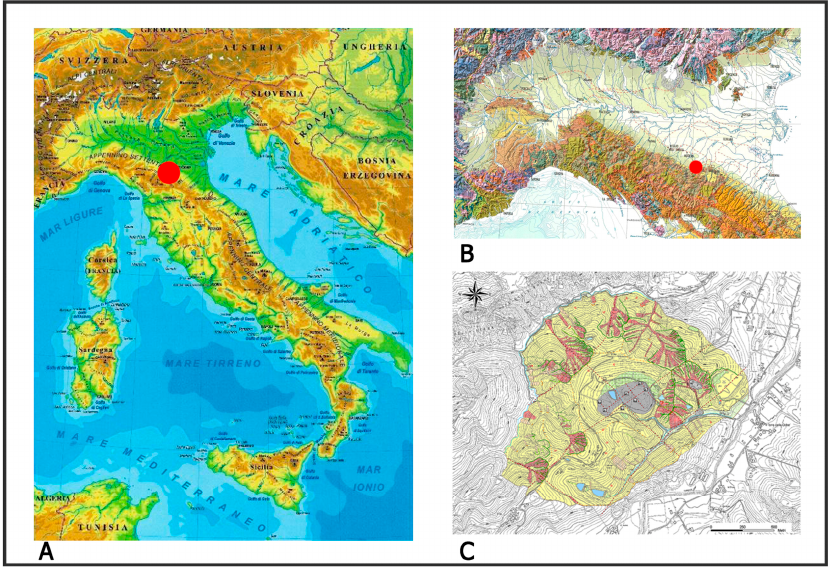
Figure 1. Localization of the study site ( A , B ) and geomorphological map of the Regional Natural Reserve of “Salse di Nirano” ( C ) from Castaldini et al., 2005 [6].